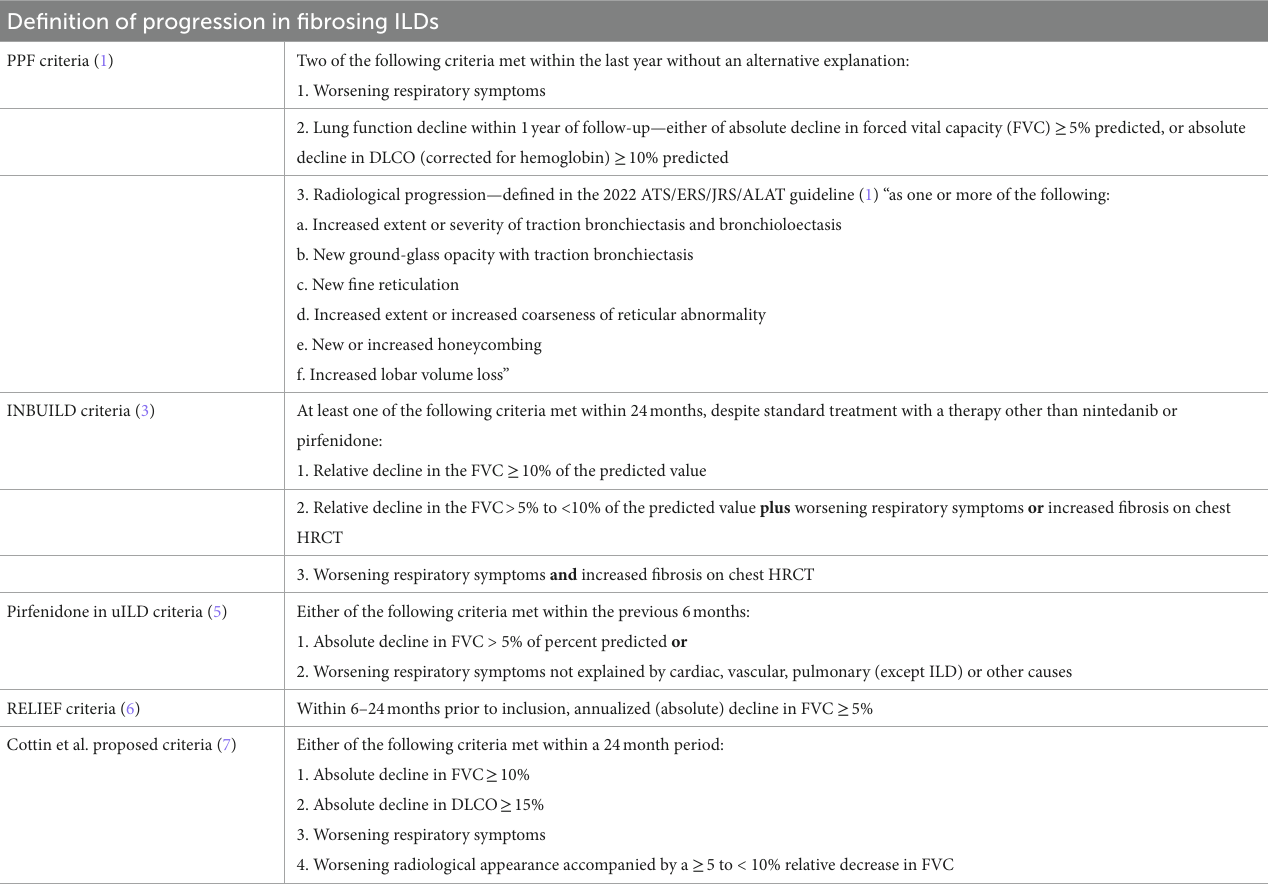
TABLE 1 Summary of several definitions which could be used in clinical practice to define progression of fibrosing interstitial lung diseases. Definition of progression in fibrosing